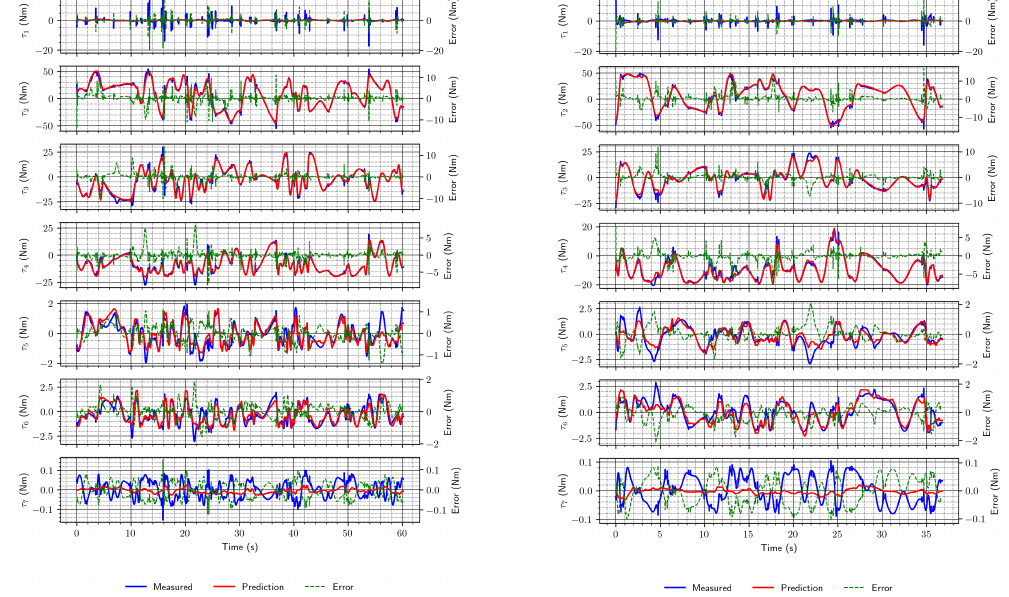
Figure 8. Two examples of torque estimates using the DeLaN architecture with external forces